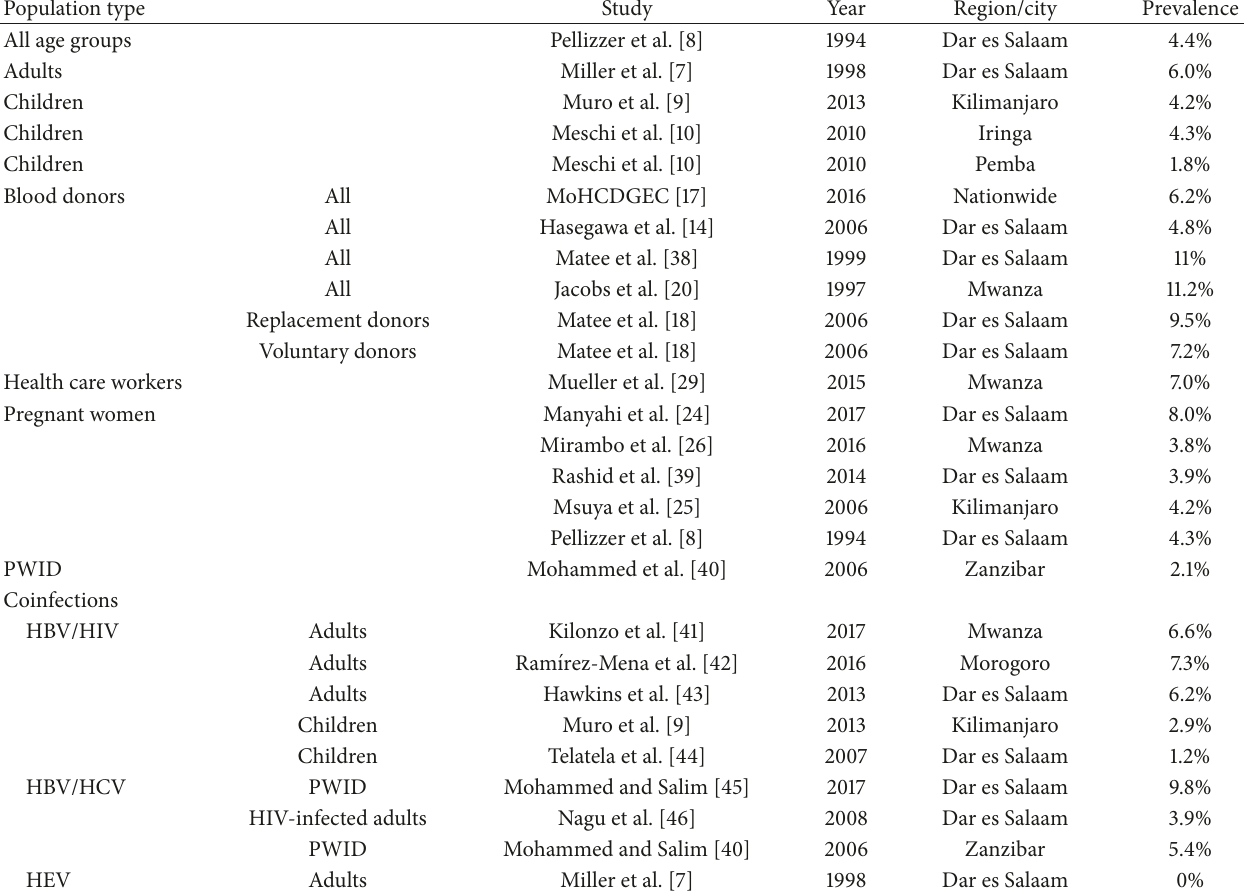
Table 2: Hepatitis B prevalence in Tanzania among different population